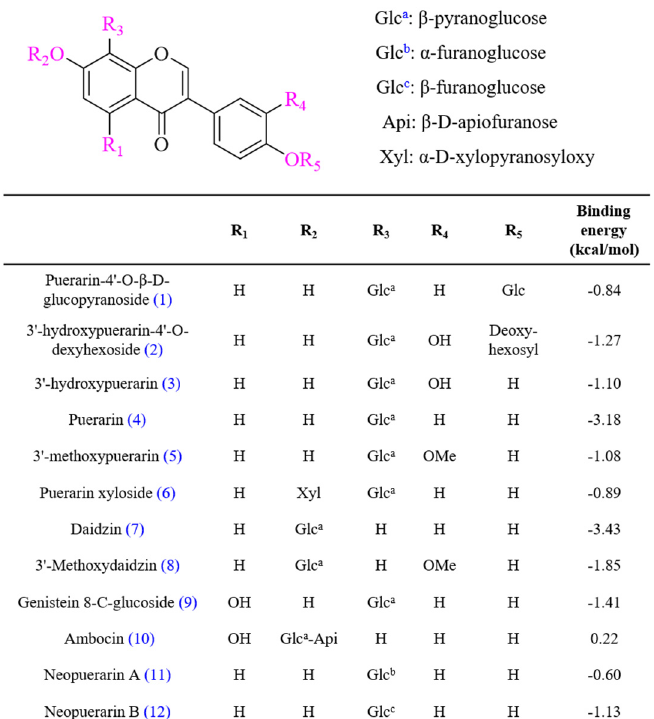
Figure 3. Chemical structures and binding energies of isoflavonoids identified from enriched PLS extract.